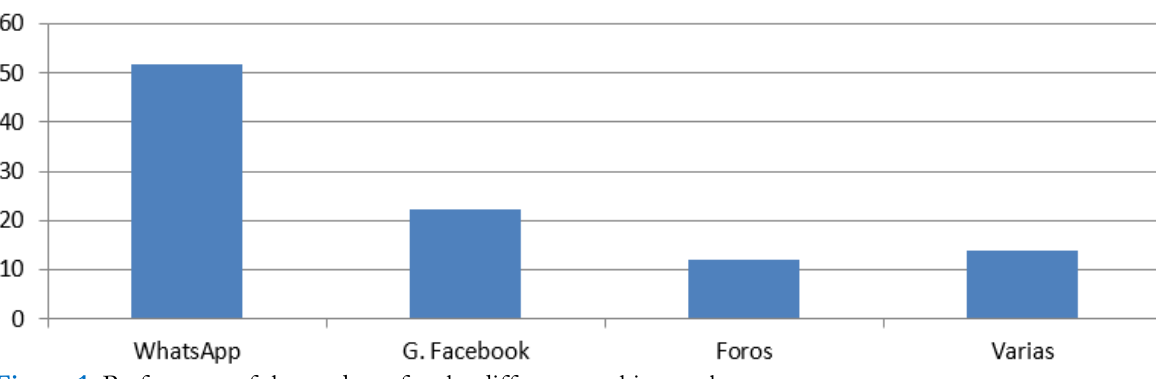
Figure 1. Preferences of the students for the different teaching